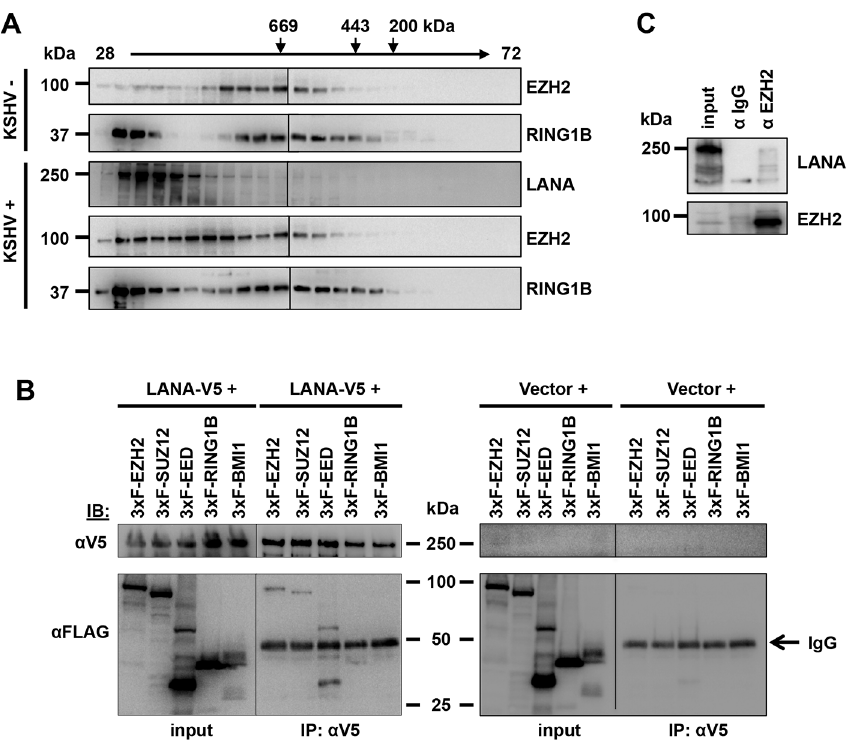
Fig 6. Interaction of LANA with PRC2. (A) Gel filtration chromatography of nuclear extracts derived from iSLK and iSLKBAC16 cells. Fractions from 28 to 72 were tested by immunoblot analysis for LANA and polycomb proteins. Molecular weight markers are indicated. (B) Co-immunoprecipitation of LANA-V5 (using V5 antibody) from 293T cells expressing LANA-V5 and the indicated 3xFLAG-tagged PRC2 (EZH2, SUZ12 and EED) or PRC1 (RING1B and BMI-1) factors. Immunoprecipitation and input blots were probed with V5 and FLAG antibodies. (C) Cell lysates derived from de novo KSHV infected iSLK cells (72 hpi) were used